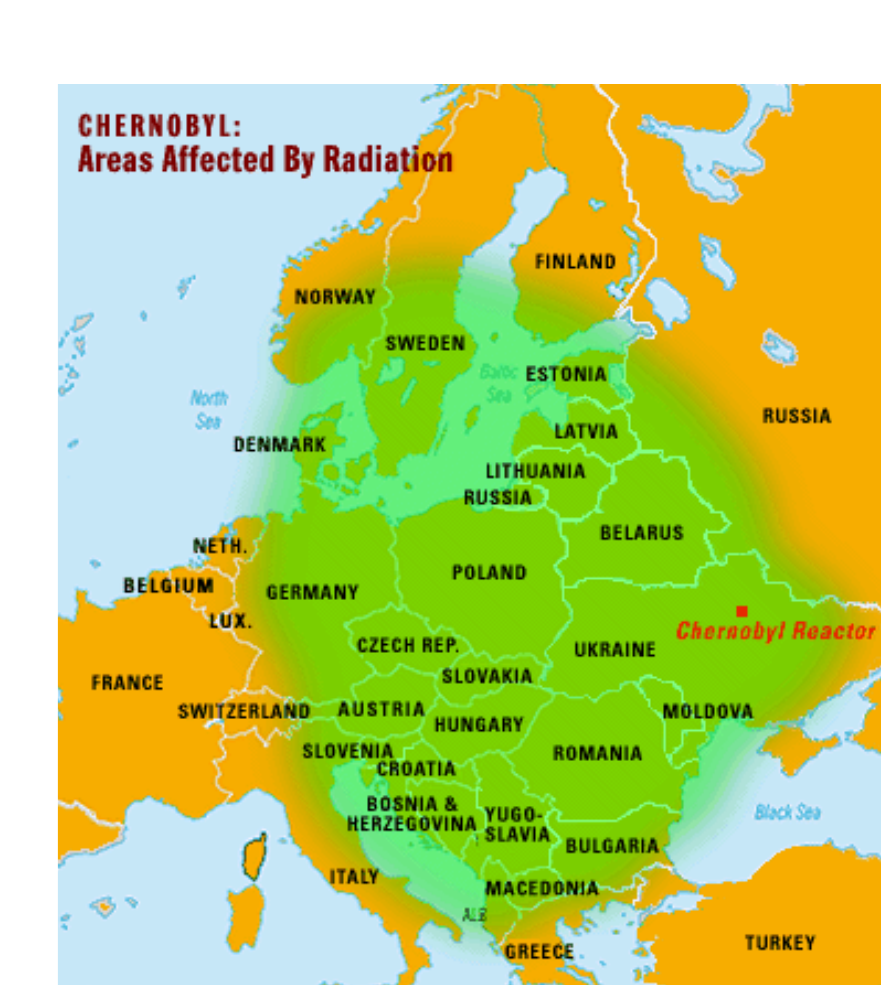
Figure 3 – Radiological contamination after the Chernobyl disaster (Amidži ć , 2006) Рис . 3 – Радиоактивное загрязнение после Чернобыльской